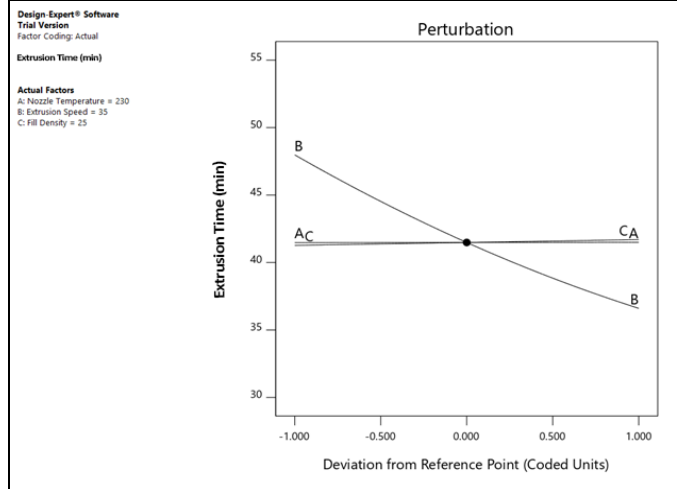
Fig. 8. Perturbation plot in measuring extrusion time.